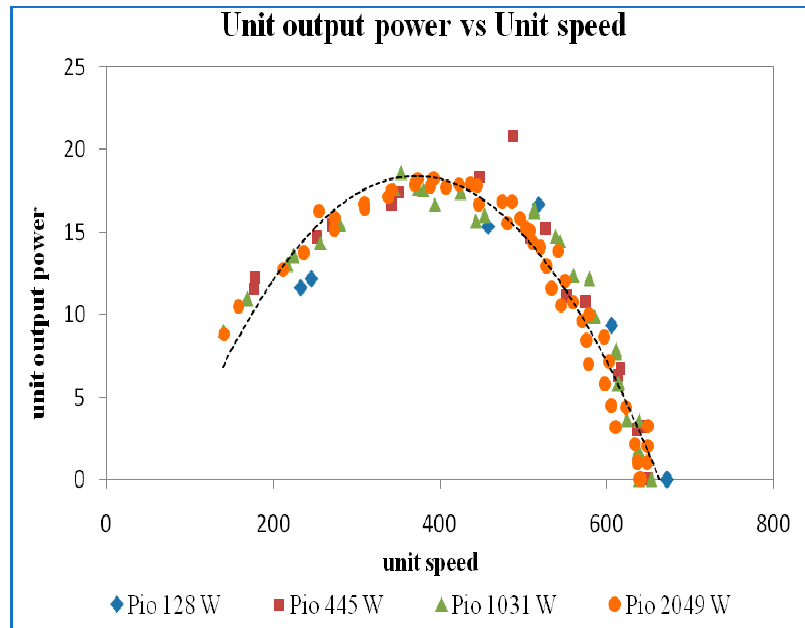
Figure 26. Unit output power vs. unit speed at a guide vane opening of 10 mm. For the 10 mm guide vane opening, the maximum efficiency is obtained for unit speed of 400, as shown in Figure 27. The highest efficiency is about